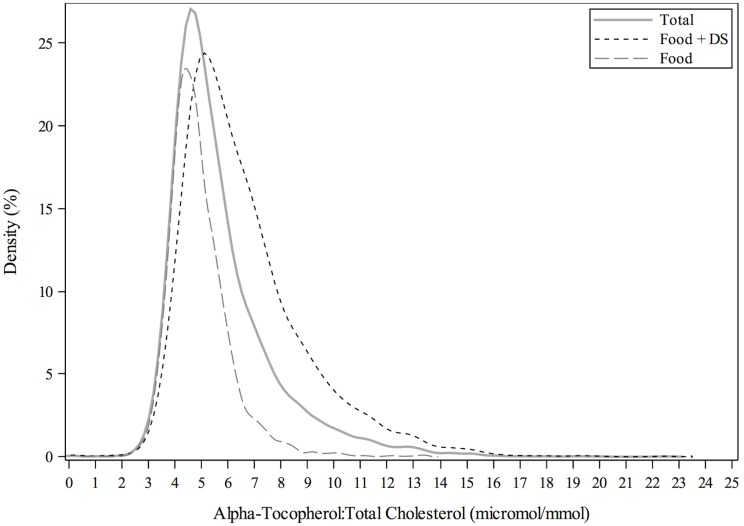
Distribution of serum α-tocopherol:total cholesterol concentrations among individuals ≥20y, excluding pregnant or lactating women, stratified by supplement use.Lines represent density (as a percentage) through non-parametric kernel density estimation.